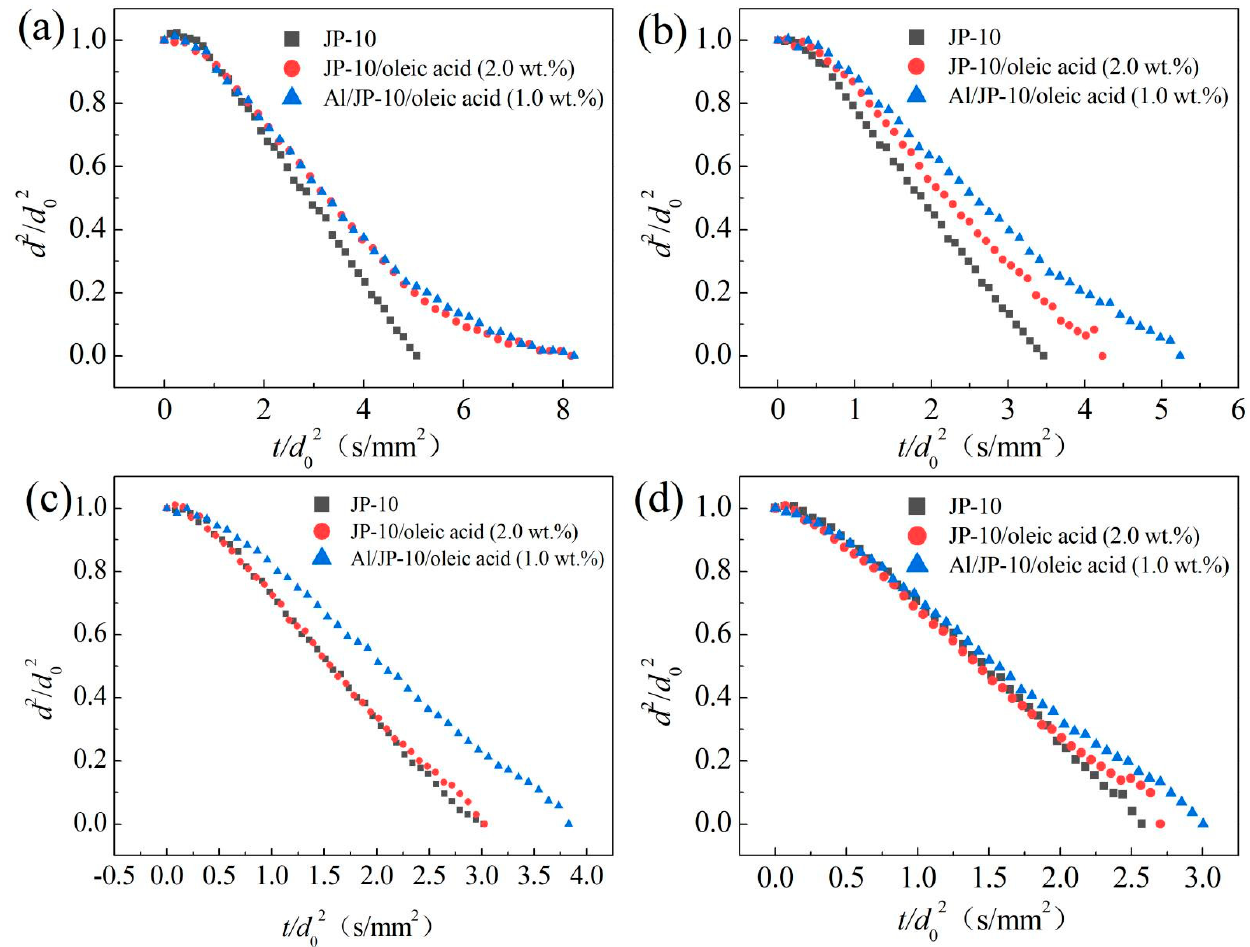
Figure 11. Evaporation of the JP-10, JP-10/oleic acid, Al/JP-10/oleic acid fuels at different ambient temperatures. ( a ) 300 °C, ( b ) 400 °C, ( c ) 500 °C, ( d ) 600 °C.